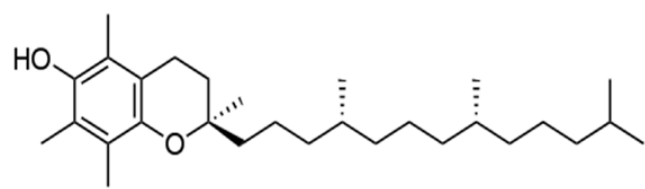
Fig. 1. molecular structure of Tocopherol